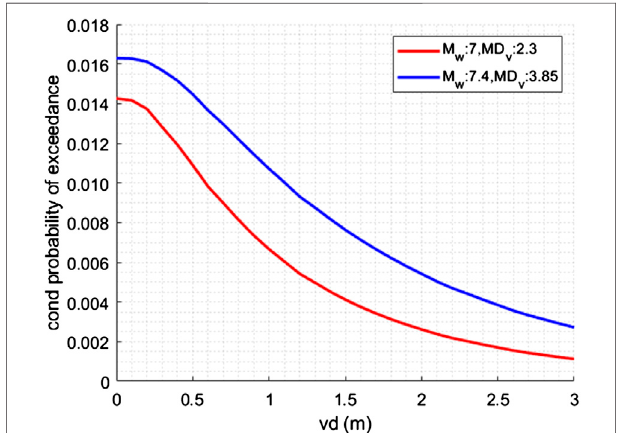
FIGURE 13 | Conditional probability of exceeding a vertical displacement, vd , on a distributed rupture at a distance r (cid:2) 510 m from the principal fault (PF) on hanging wall side for two modeled scenarios on Suasselkä fault: scenario 1 of M w 7 and maximum vertical displacement on PF ( MD v ) of 2.3 m (red), and scenario 2 of M w 7.4 with a MD v of 3.85 m (blue).